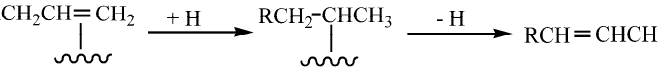
Table 3. Reactions of C 6 H 12 and C 8 H 16 in H 2 atmosphere (T = 533 K, p = 0.8 MPa).